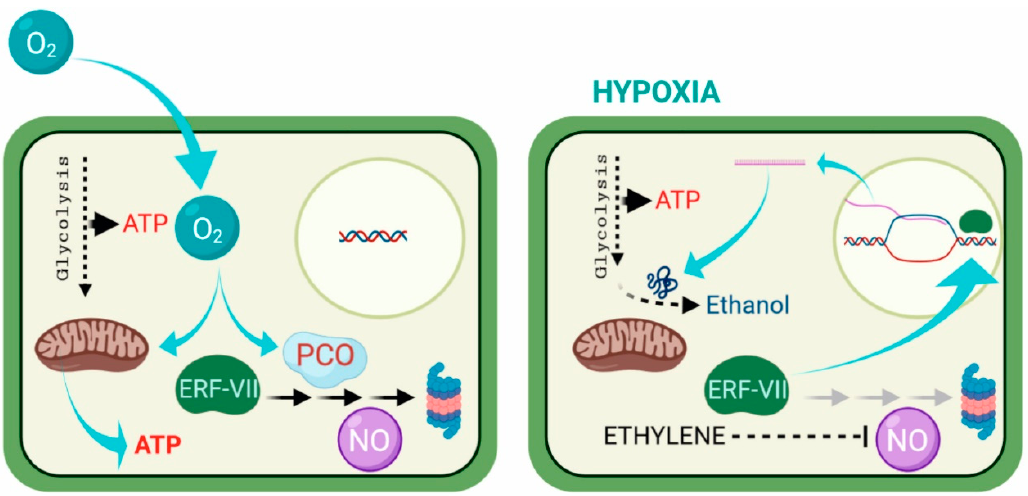
Figure 1. How plants sense oxygen. Under aerobic conditions (left), aerobic respiration in the mitochondria provides most of the energy (ATP) required for the cell metabolism. The ERF-VII transcription factor genes are constitutively expressed, but their stability is compromised by the activity of PCOs, which, in a process requiring oxygen, oxidize the N-terminal Cys residue, channeling the ERF-VII proteins to the proteasome, in a process also requiring nitric oxide (NO). Under hypoxia (right), the respiration in the mitochondria is drastically reduced, and ATP production can only occur because of enhanced glycolytic activity. The ERF-VII proteins are stabilized because of the absence of oxygen and also thanks to ethylene production, which dampens the presence of NO in the cell. The stable ERF-VII proteins migrate to the nucleus where they activate the transcription of Hypoxia-Responsive Genes (HRGs), including genes encoding proteins required for alcoholic fermentation. This figure was created using BioRender [17].